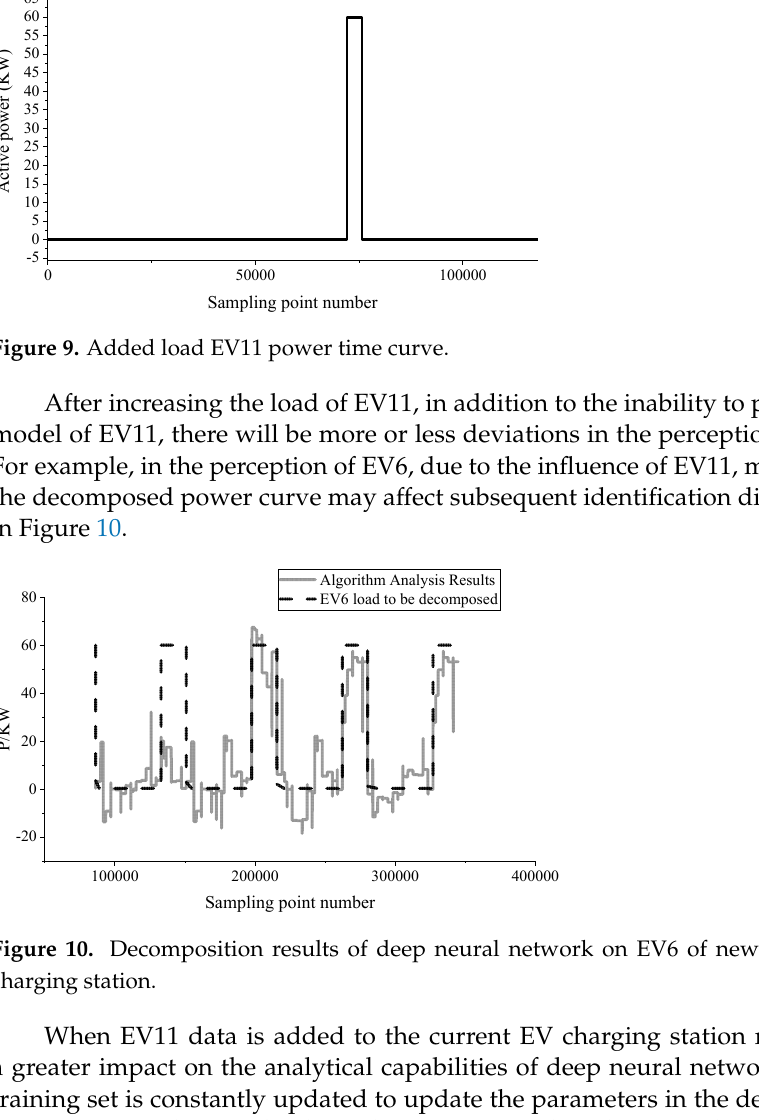
Figure 11. K ‐ means clustering results for electric vehicle charging stations without new random loads.